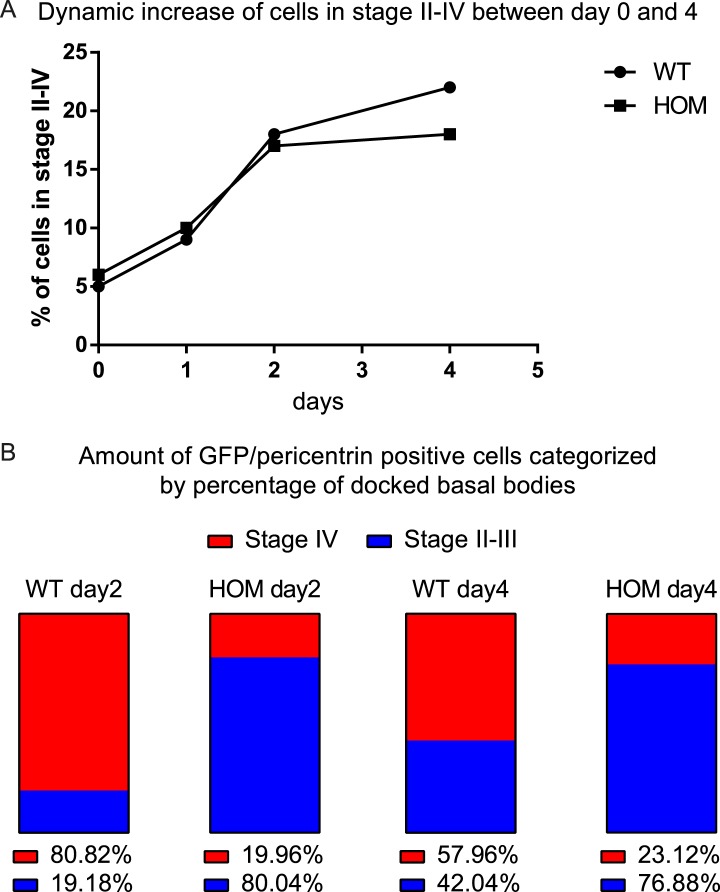
ALI differentiation efficiency and quantification of BB docking defect.(A) Graph showing the percentage of cells in stage II–IV for WT and FltpZV/ZV (HOM) ALIs at day zero (before the switch to ALI condition), one, two, and four measured by GFP and pericentrin (HOM) and only pericentrin (WT) staining compared to the total amount of cells in the ALI culture stained by DAPI (representative images were analyzed). For WT analysis we counted n = 1 (1493 cells) for day 0, n = 1 (1345) for day 1, n = 2 (1635) for day 2, n = 2 (1262) for day 4 and for HOM n = 1 (1367 cells) for day 0, n = 1 (1542) for day 1, n = 3 (942) for day 2, n = 4 (1123) for day 4. (B) Shows the percentage of ciliation (measured by acetylated-Tubulin staining) of cells with amplified centrosomes (measured by pericentrin staining) for WT and HOM ALIs at day two and four categorized into stage II–III and stage IV. For WT analysis we counted n = 4 (609 cells) for day 2, n = 4 (231) for day 4 and for HOM n = 10 (611) for day 2, n = 7 (286) for day 4.